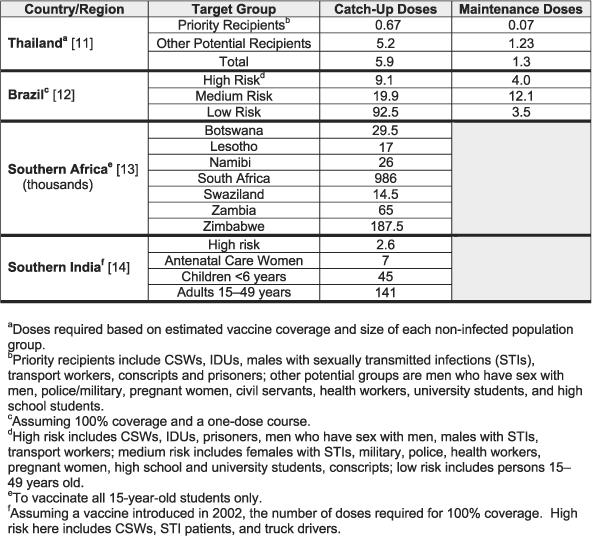
Number of Doses of HIV Vaccine Required by the Public Sector (in Millions, Unless Otherwise Indicated), Four Country Studies